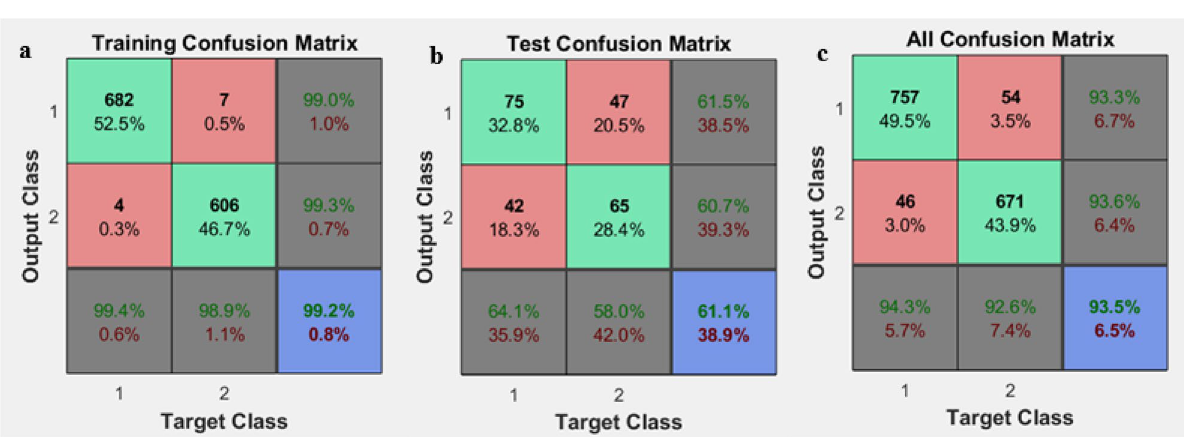
Figure 4. An example of confusion matrices after GA implementation in integration with ANN for selecting the effective factors. Training confusion ( a ). Test confusion ( b ) and all confusion ( c ).